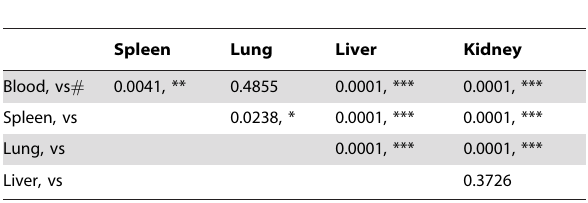
Table 1. P values derived from statistical analyses of frequencies of dominant V d 2 clonotypes between different tissues compartments